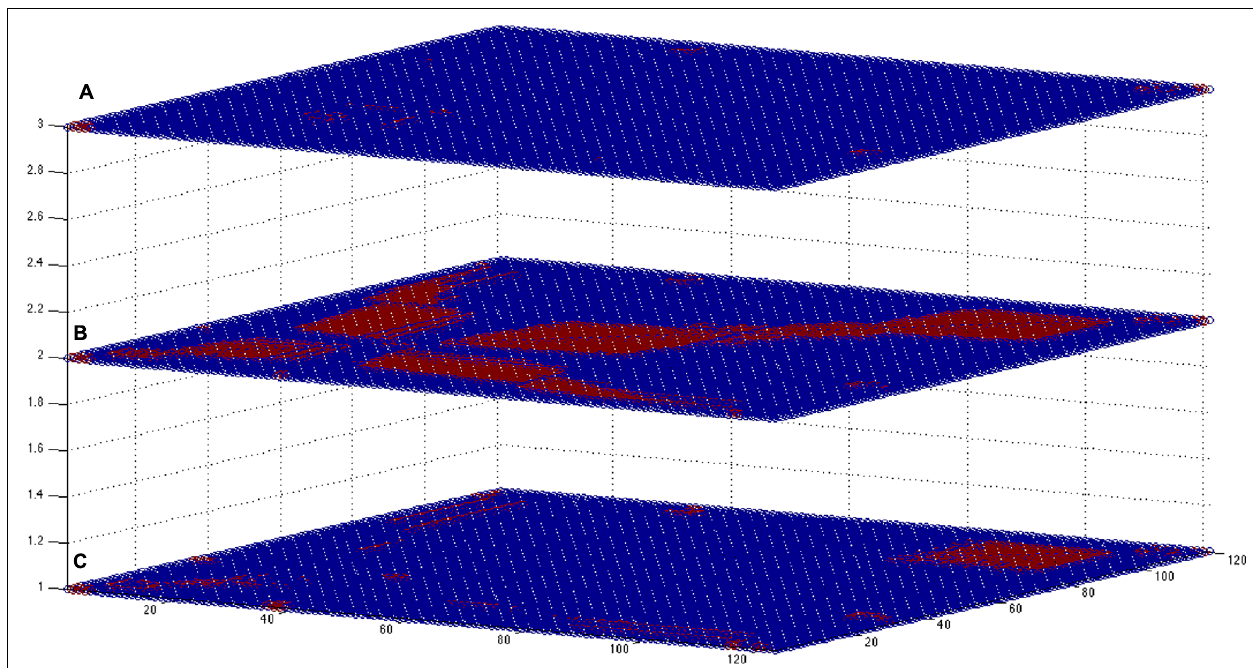
sleep state): about 5.2% of the possible N ( N − 1) links are the same for networks (A) and (B) , whereas for the other intersections the values are about 10 times smaller (0.3–0.5%). Adequate sampling statistics may help to define specific patterns characterizing each rearing state, and similarity measures can be performed to classify the different